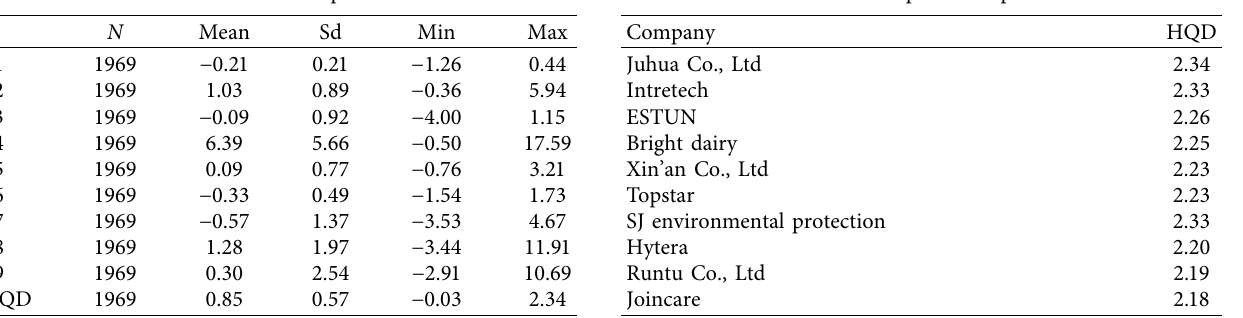
Table 10: Indicator descriptive statistics. Table 11: Top 10